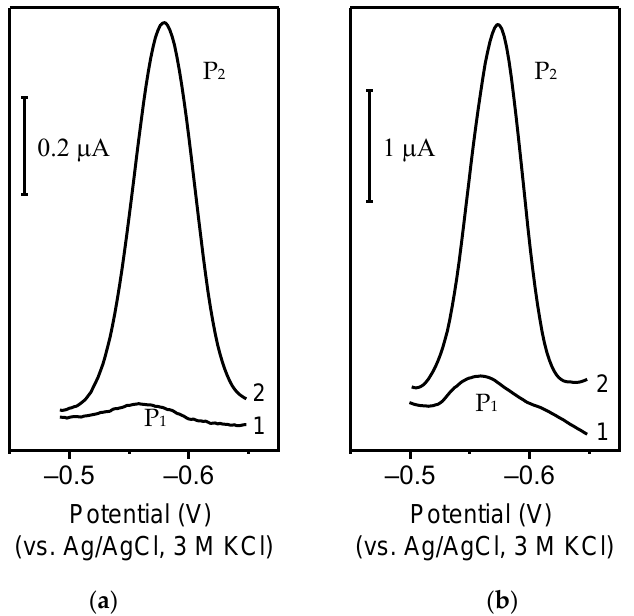
Figure 9. DP AdSV curves recorded for a solution containing 25 nM of Ge (IV) and chloranilic acid, in the absence (curve 1) and presence of V(IV)-HEDTA (curve 2) using the HMDE ( a ) and Hg(Ag)FE ( b ). Supporting electrolyte: ( a ) 0.1 M of acetic acid, 0.5 mM of chloranilic acid, 1.5 mM of V(IV), 3 mM of HEDTA; ( b ) 0.075 M of acetic acid, 0.77 mM of chloranilic acid, 1 mM of V(IV), 2 mM of HEDTA. Instrumental parameters: E acc = − 0.1 V, t acc = 60 s Reprinted with permission from ref. [43].